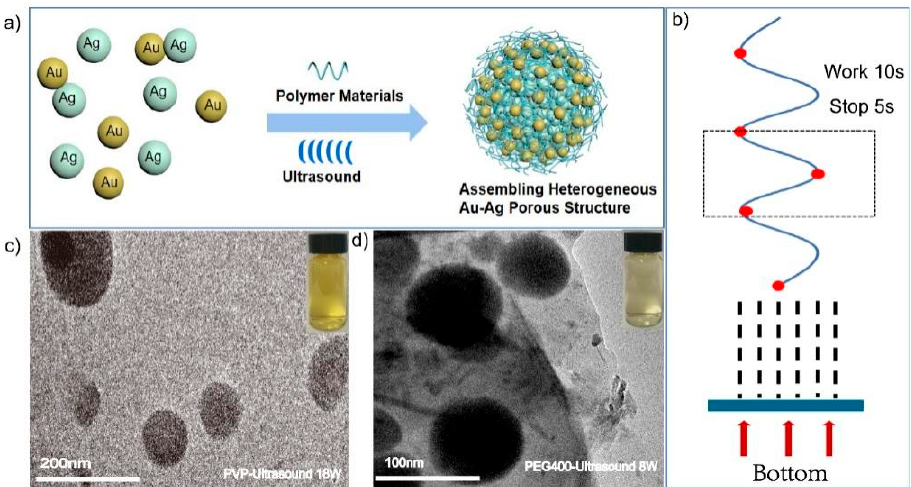
Figure 8. ( a ) Schematic diagram of formation and synthesis of heterogeneous assembly structures of precious metal NCs (Au, Ag) under ultrasonic conditions; ( b ) Simulation model while applying ultrasound fields (6 MHz, 8 W, 13 W, 18 W) from bottom incentive (ultrasonic emission 10 s, stop 5 s); ( c ) TEM images of Au-Ag cluster @PVP prepared at 18 W ultrasonic power; ( d ) TEM images of Au-Ag cluster @PEG400 prepared at 8 W ultrasonic